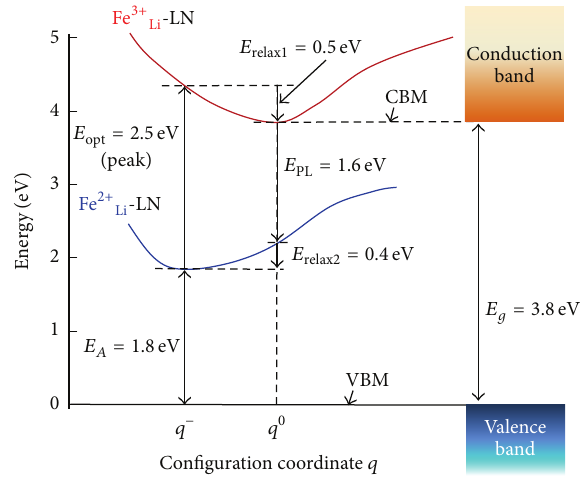
Figure 6: Schematic illustration of the configuration coordi- nate ( q ) diagram showing the optical absorption ( 𝐸 opt ), Frank- Condon relaxations ( 𝐸 relax 1 and 𝐸 relax 2 ), and photoluminescence ( 𝐸 PL ) accompanied by the valence and conduction bands with an 𝐸 𝑔 of 3.8 eV.